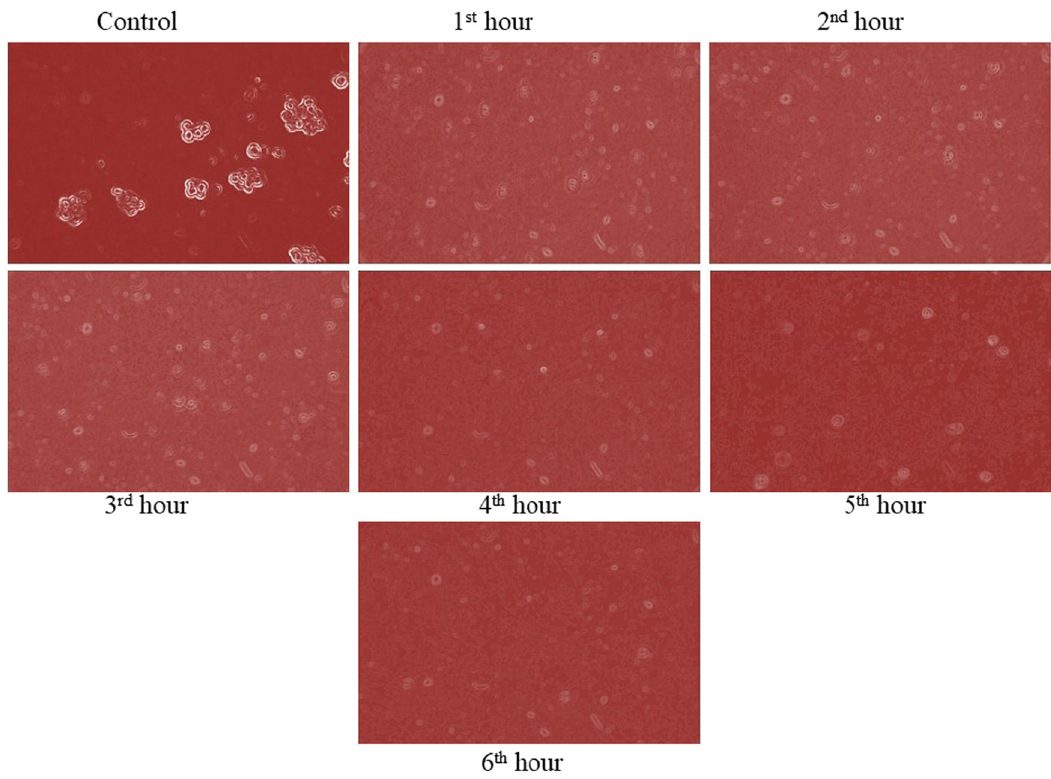
Figure 5: Anticancer activity of Ce - doped TiO 2 .